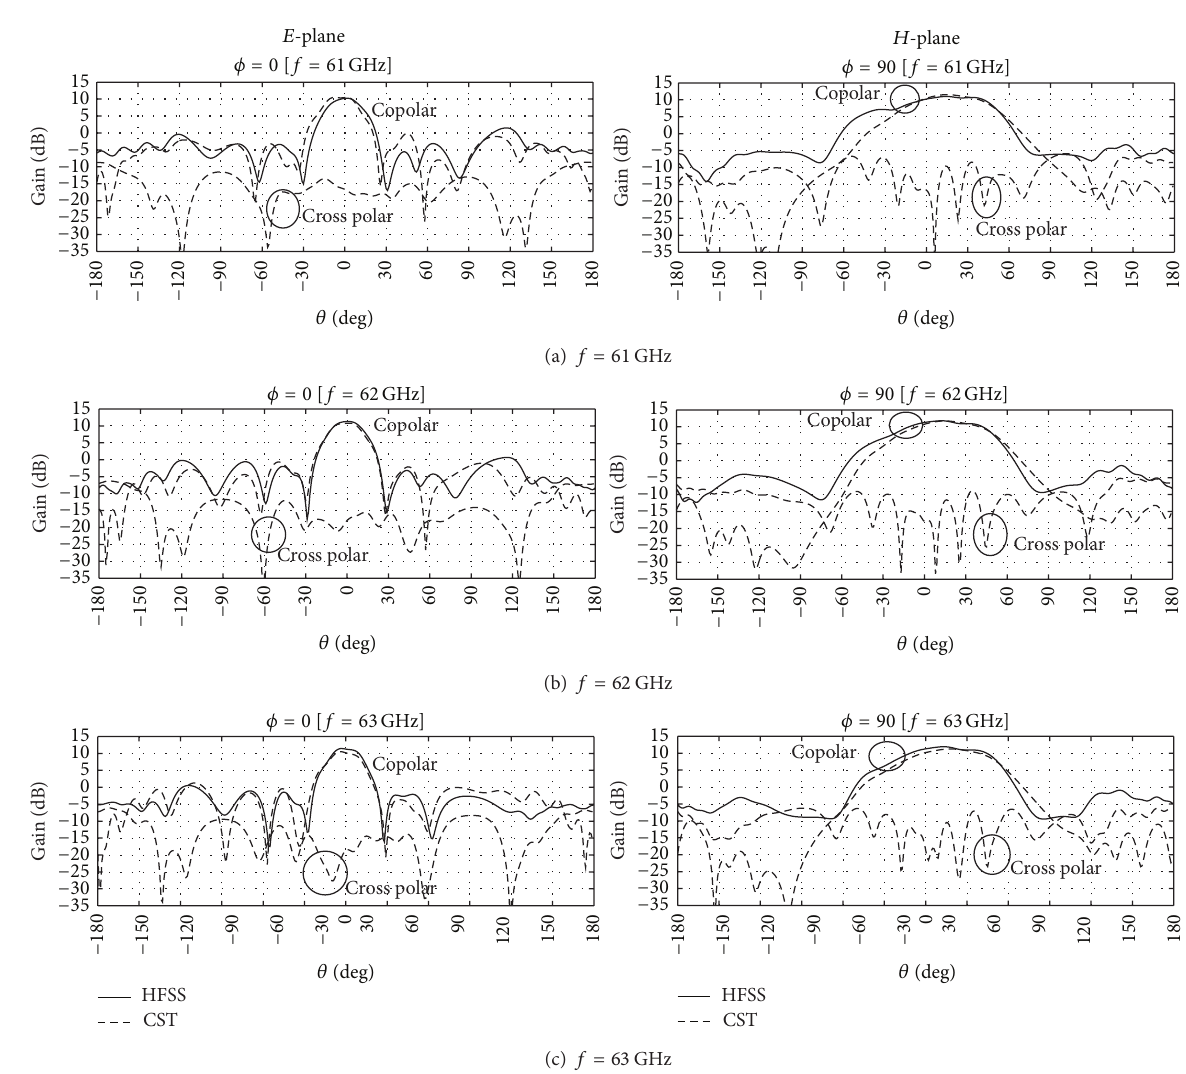
Figure 9: 𝐸 -plane and 𝐻 -plane radiation patterns for SIW 1 × 4 antenna